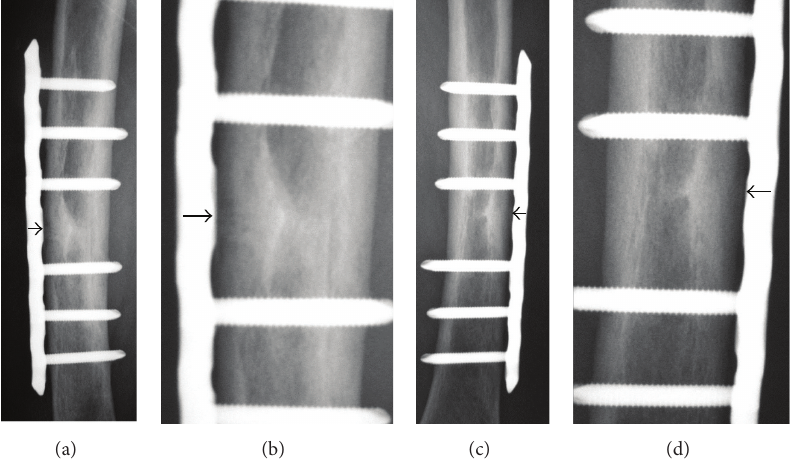
Figure 6: Anteroposterior radiographs of the bilateral femurs ((a) right femur; (c) left femur) 6 months after surgical treatment. (b) and (d) are magnified views of (a) and (c), respectively. The horizontal lines over the outer cortical bone (black arrows) had almost